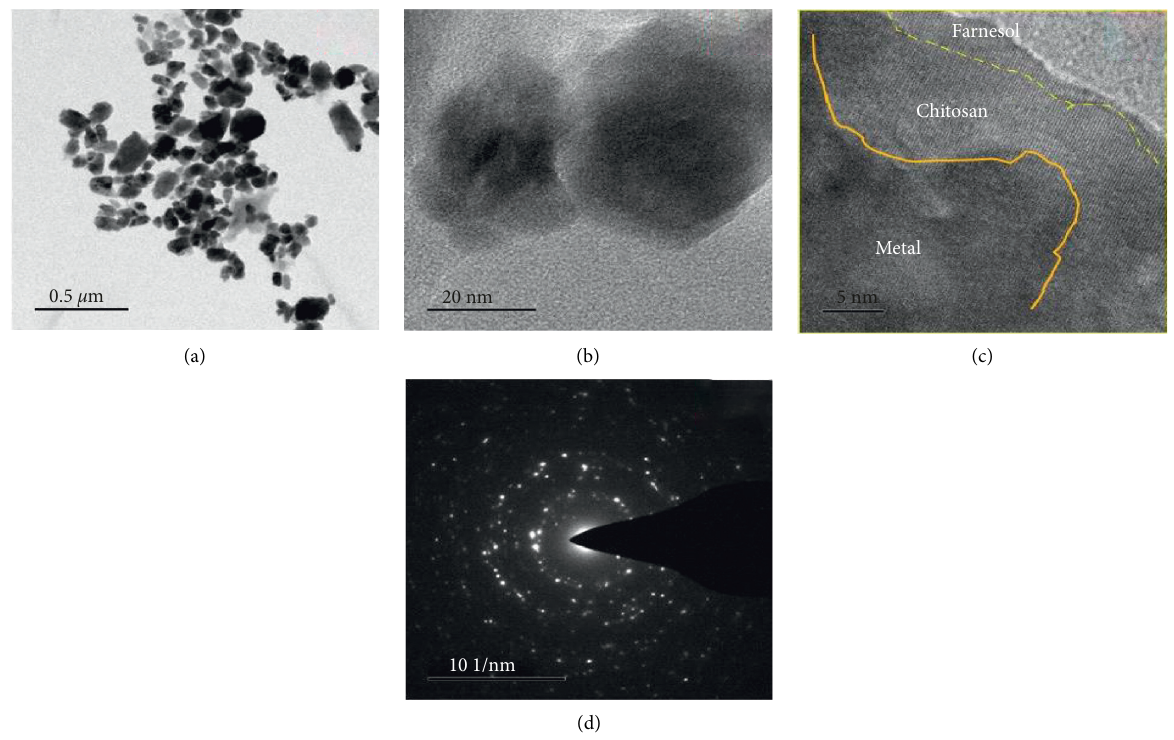
Figure 3: ZnO-TiO 2 -chitosan-farnesol NCs SAED pattern (d) in lower and higher magnification TEM images